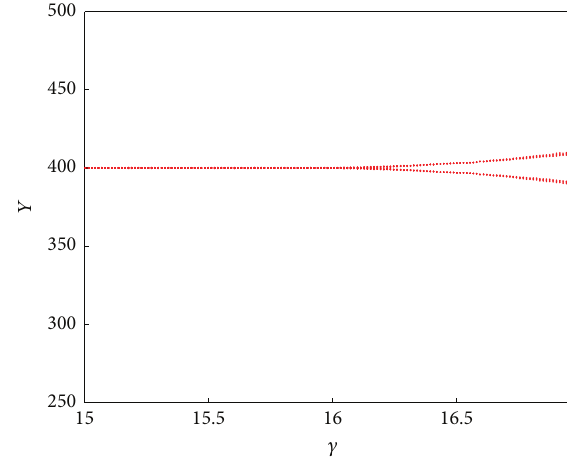
Figure 2: Bifurcation diagram (case with (28)). Figure 3: Bifurcation diagram (case with